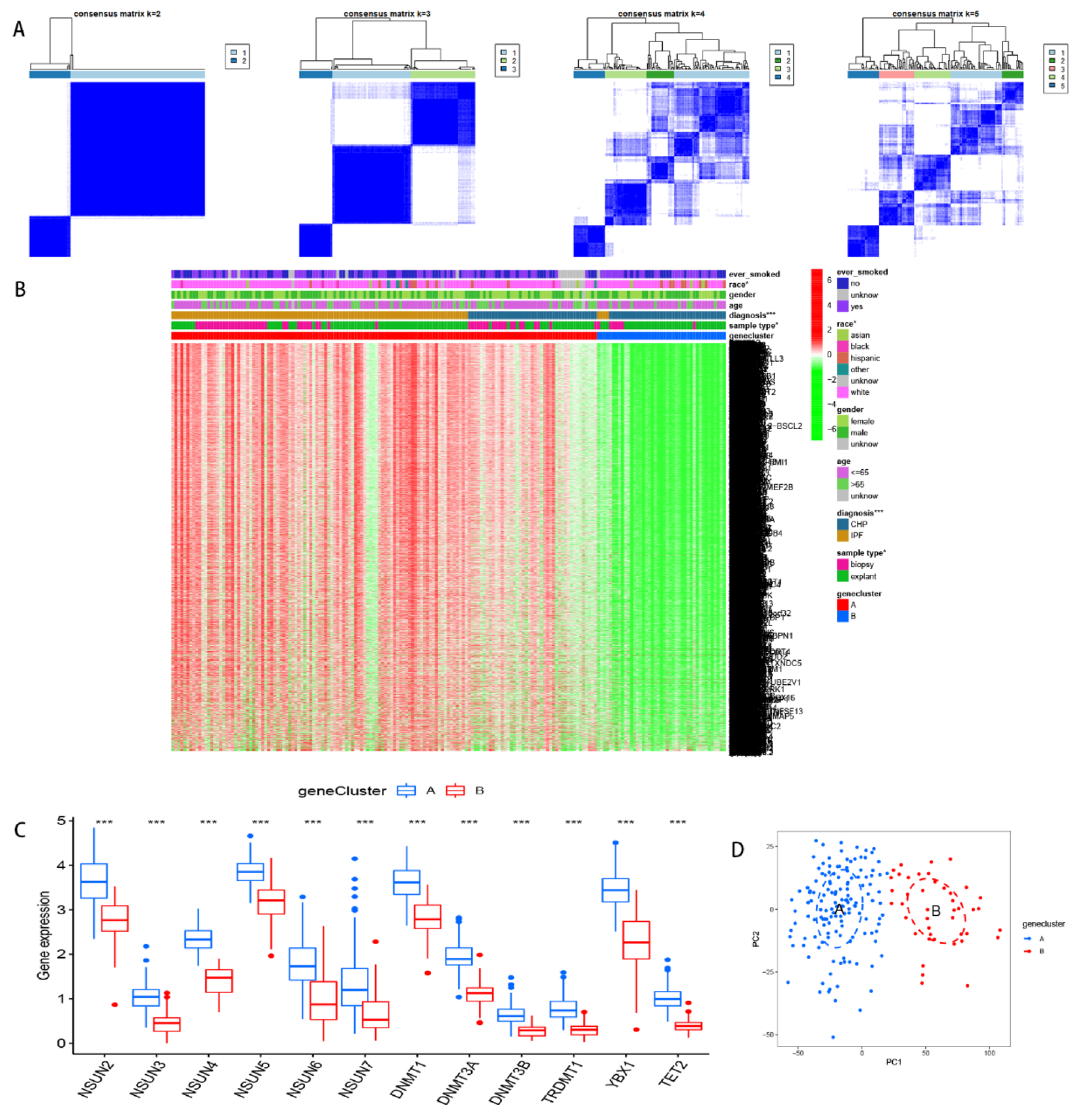
Figure 9. Consensus clustering of the 3346 m5C-related DEGs. ( A ) Consensus matrices of the DGEs (k = 2–5). ( B ) Expression of the DEGs in gene cluster A and cluster B. ( C ) Expression of the 12 m5C regulators in gene cluster A and cluster B. ( D ) Principal component analysis for the expression profiles of gene subtypes, also showing a remarkable difference between different modification patterns. * p < 0.05, ** p < 0.01, and *** p <